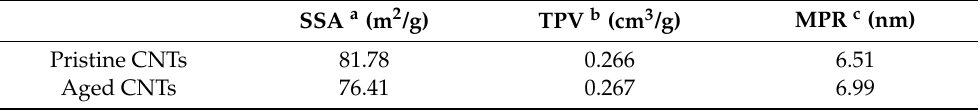
Table 2. Specific surface area and particle size distribution of pristine and aged CNTs.